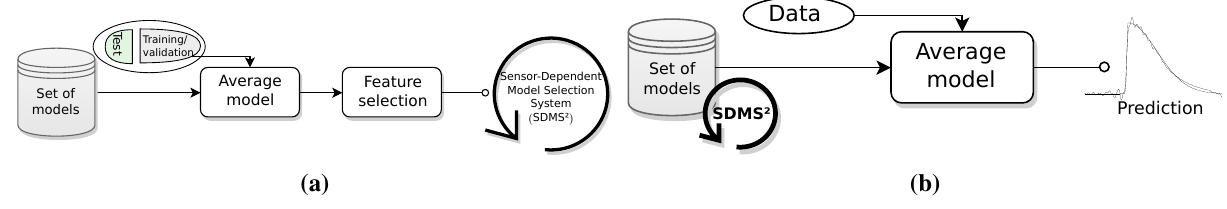
Figure 7. SDMS 2 design and usage in the real-time application. ( a ) Sensor-dependent